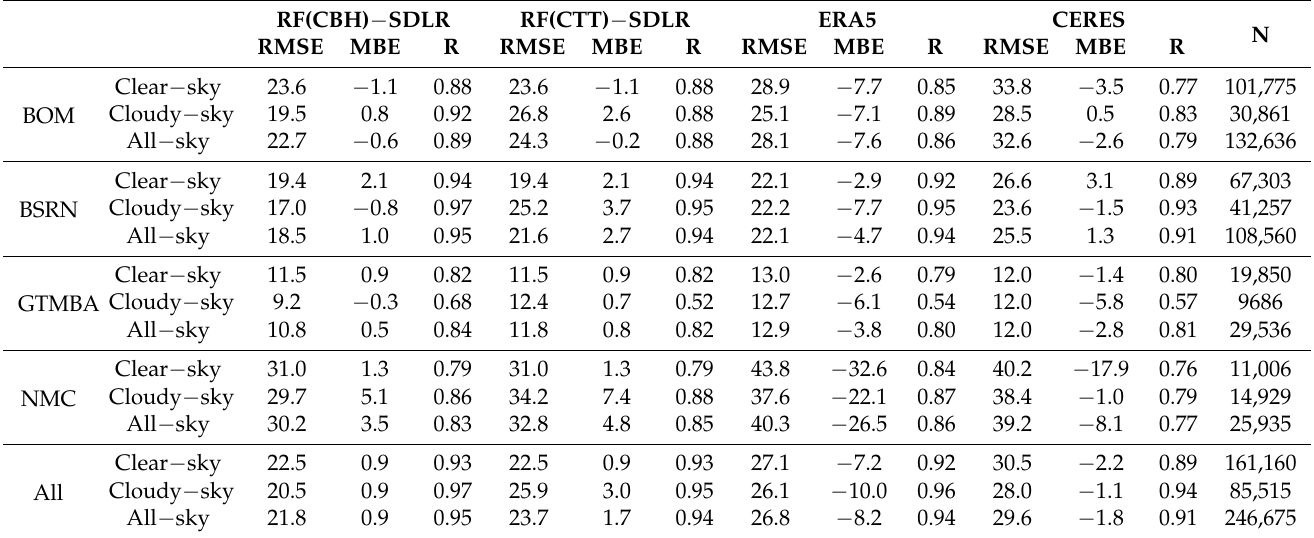
Table 4. The validation results of RF-SDLR, the surrogated parameter algorithm, ERA5 reanalysis, and CERES against different ground networks. Note that there are three stations used in this study that belong to both the BOM and BSRN